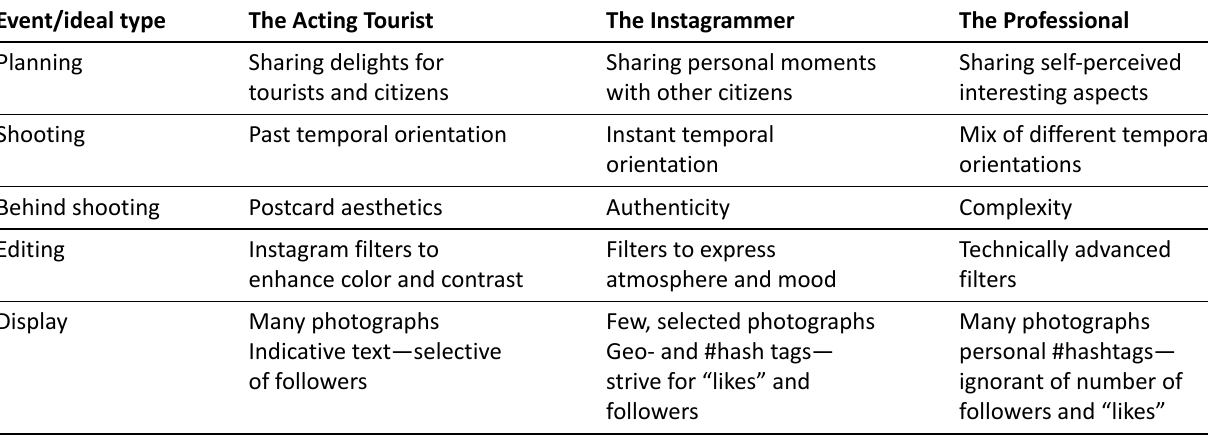
Table 1. Three ideal types of Instagram photography in the Instagram takeover project. Event/ideal type